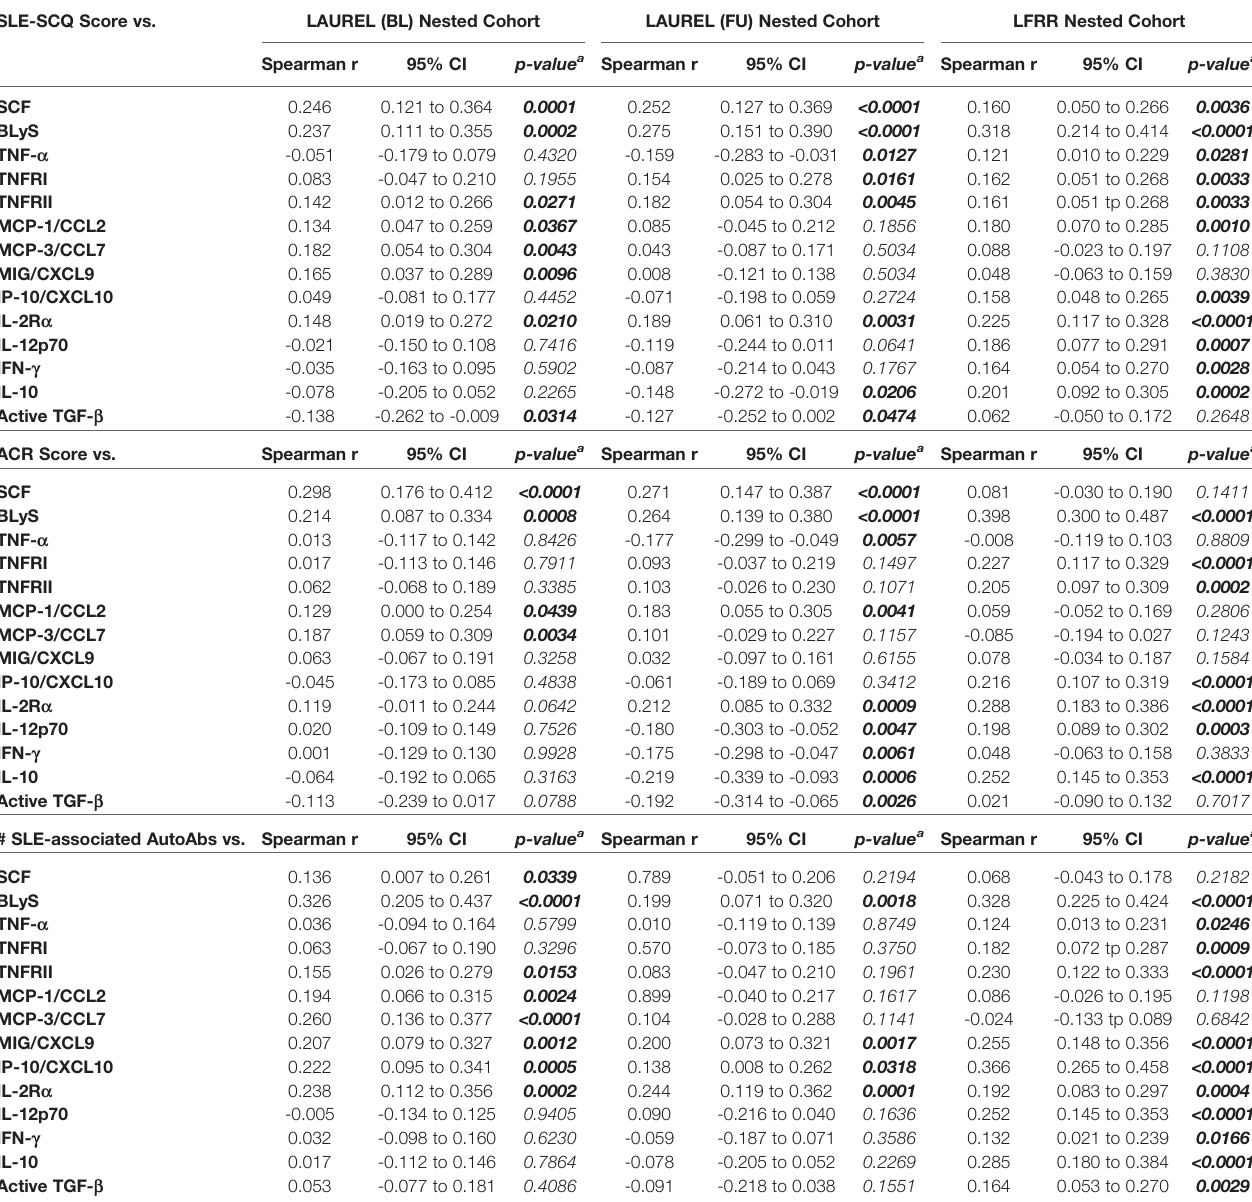
TABLE 9 | Correlation Between SLE-CSQ Score, ACR Score, or SLE-Associated Autoantibody Speci fi cities and Immune Parameters in Lupus Relatives. SLE-SCQ Score